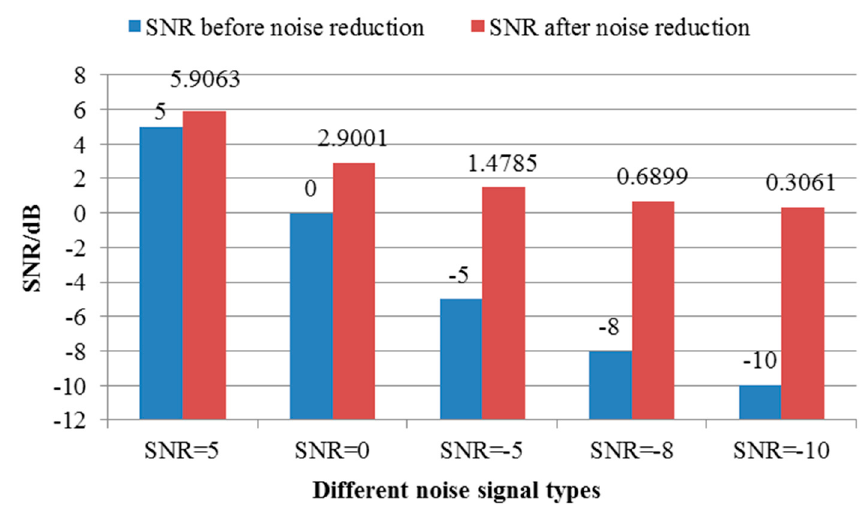
Figure 8. SNR collation map before and after noise reduction. Table 2. Cross-correlation coefficient between each component and the reference signal of the normal condition.